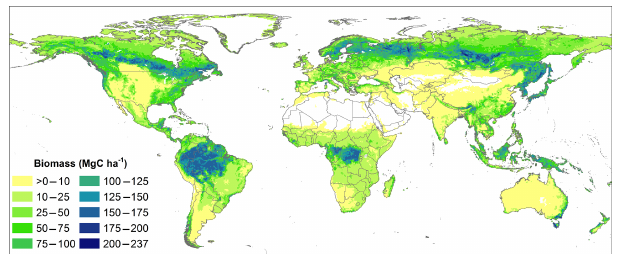
Figure 6. Estimated global carbon biomass obtained from the global fuelbed data